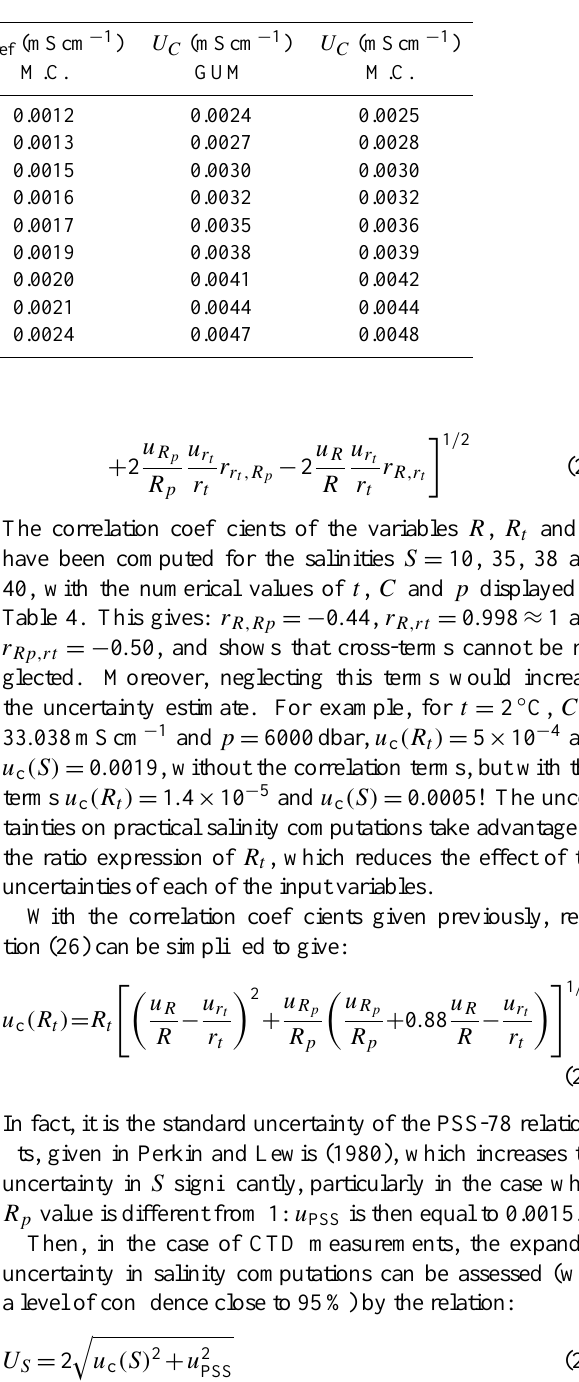
Table 3. Standard combined uncertainties on reference conductivities ( u C ref ) , computed for different values of temperature, conductivity and for S = 35, and expanded uncertainty of conductivity values measured with linearized sensors ( U C ) . U C and u C ref were assessed with the GUM and Monte Carlo Method (M.C.).